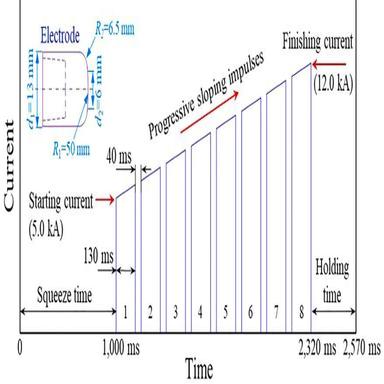
Resistance spot welding procedure and the schematic of the utilized electrode.